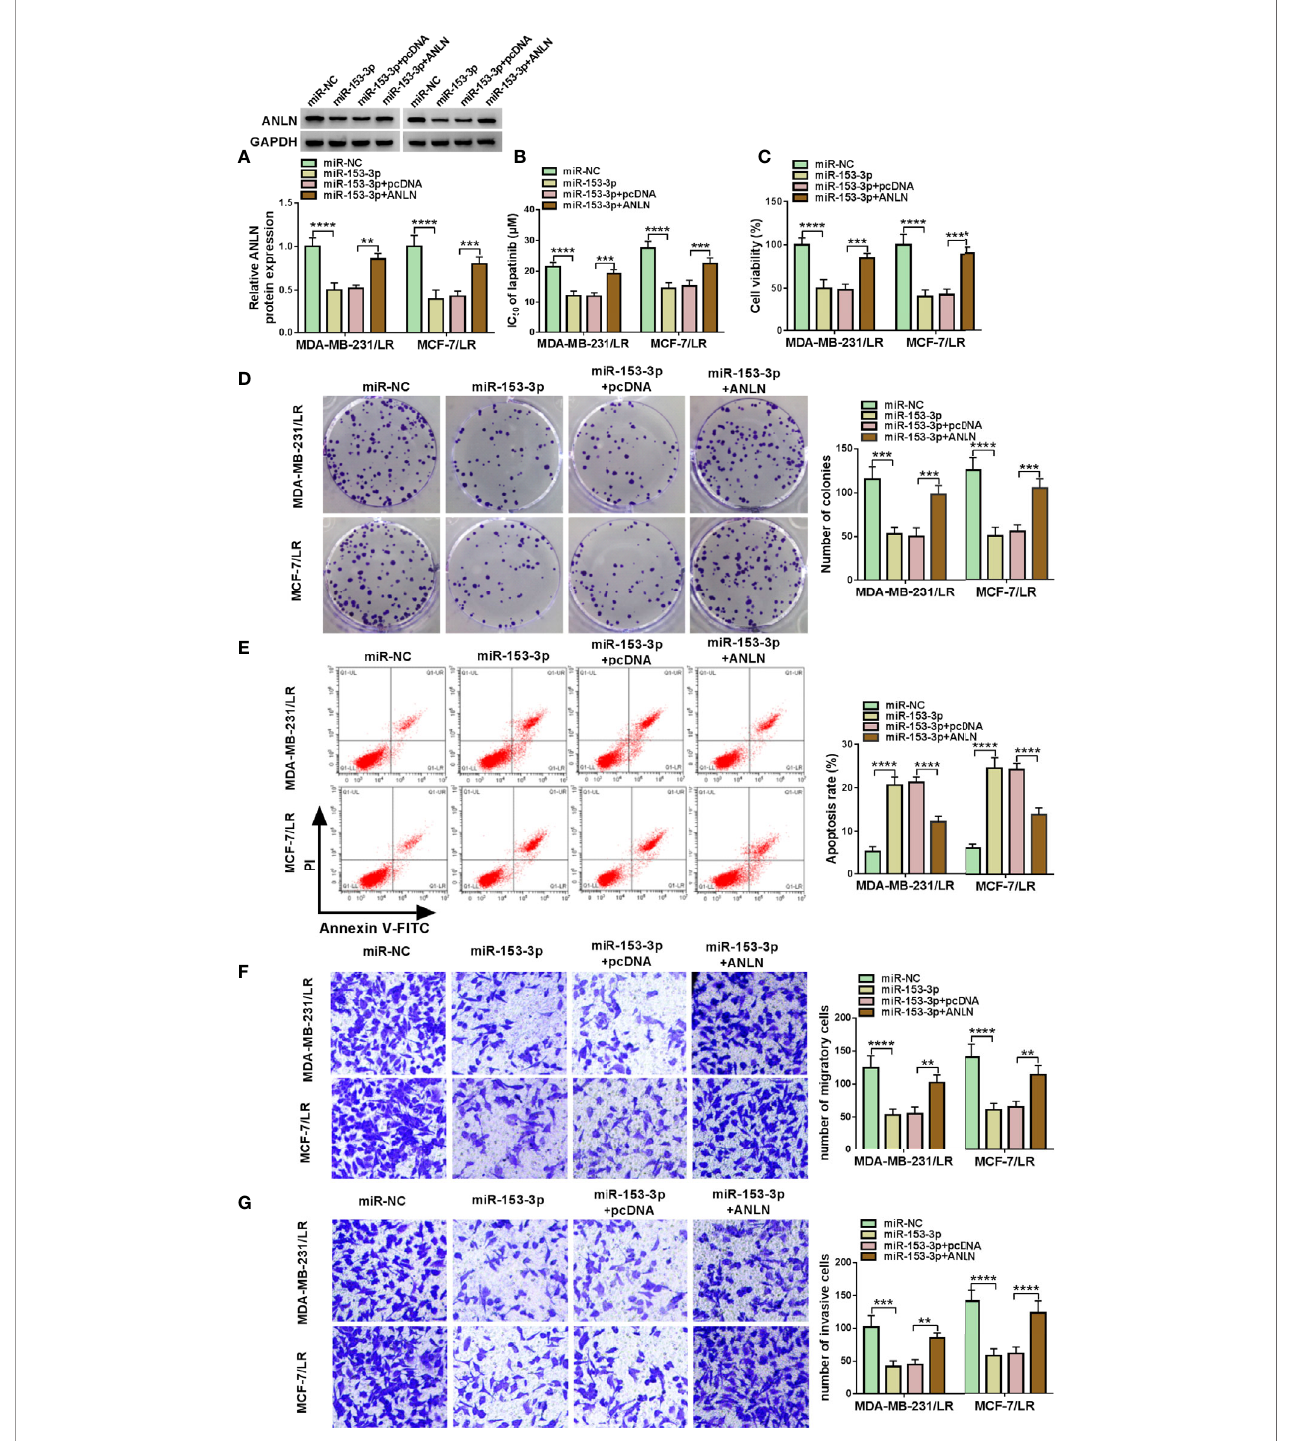
FIGURE 7 | MiR-153-3p attenuated the lapatinib resistance by targeting ANLN in LR breast cancer cells. MDA-MB-231/LR and MCF-7/LR cells were transfected with miR-NC, miR-153-3p, miR-153-3p+pcDNA, and miR-153-3p+ANLN. (A) ANLN protein level was determined in transfected MDA-MB-231/LR and MCF-7/LR cells. (B, C) IC 50 of LR and cell viability were measured in transfected MDA-MB-231/LR and MCF-7/LR cells. (D, E) Colony number and apoptosis rate were detected in transfected MDA-MB-231/LR and MCF-7/LR cells. (F, G) Migration and invasion were examined in transfected MDA-MB-231/LR and MCF-7/LR cells. ** P < 0.01, *** P < 0.001, **** P < 0.0001 (ANOVA with Tukey ’ s tests), ANLN relative to